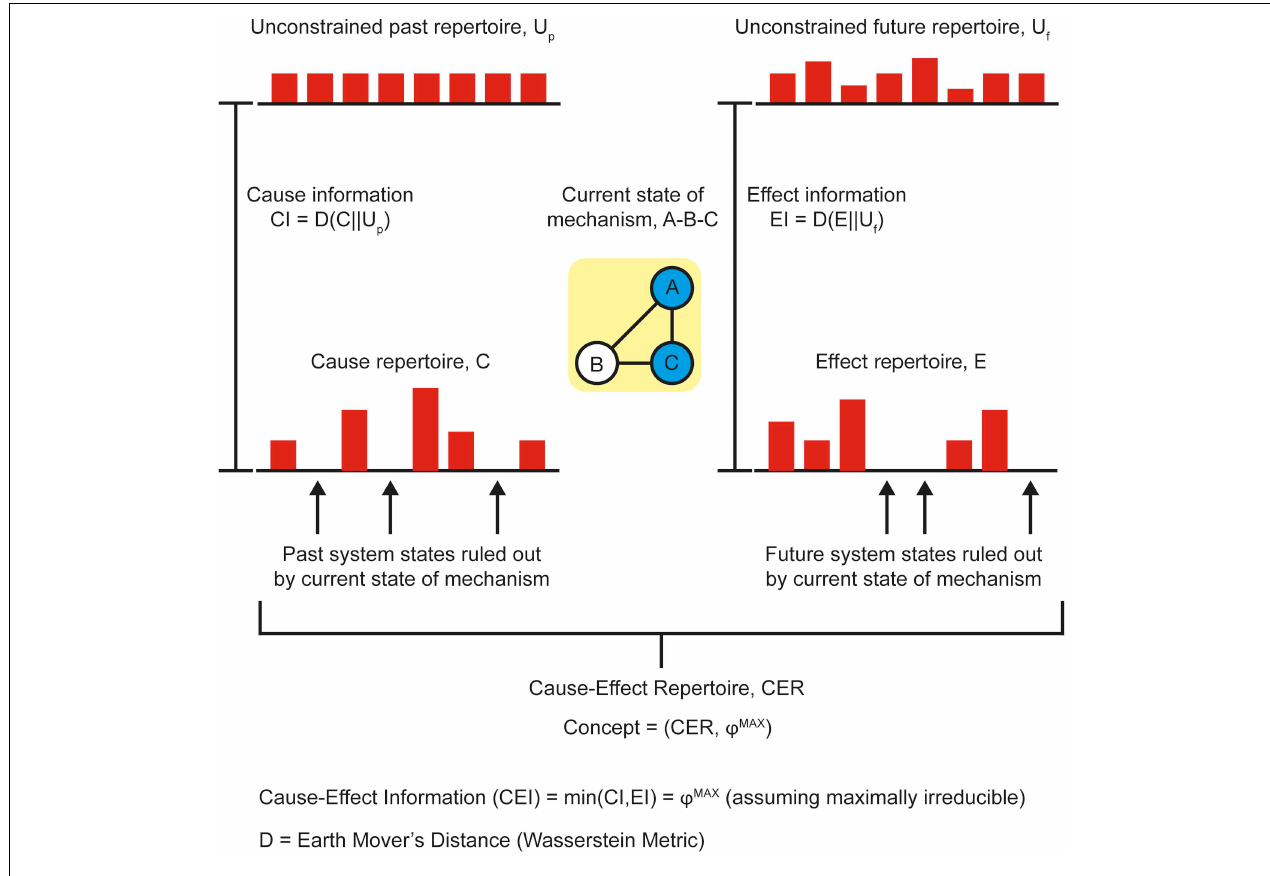
FIGURE 2 | The current state of a mechanism is associated with a specific cause-effect repertoire of past and future states of the system. The mechanism generates information by